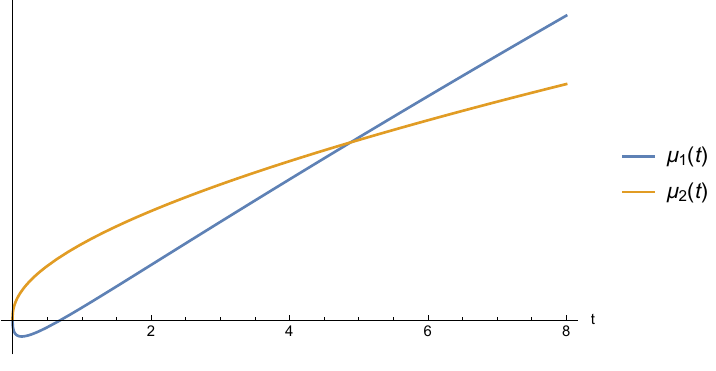
Fig. 9 The solutions of the initial value problem 40–41 for α = 0 . 4